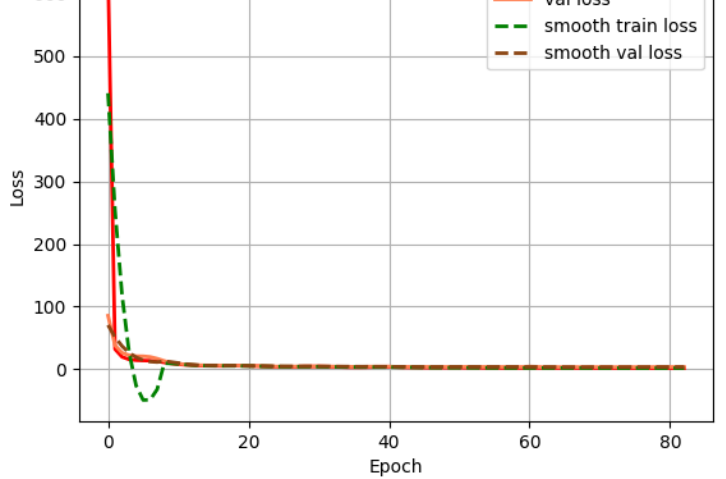
Figure 9. Loss function diagram.